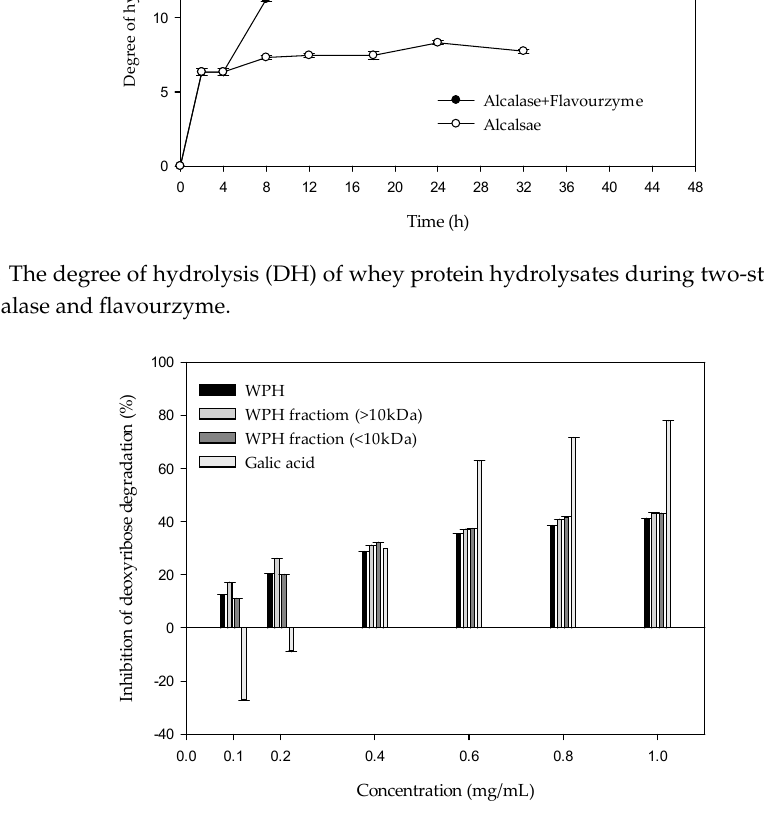
Figure 2. Effect of whey protein hydrolysate (WPH) and WPH fractions on the Fe 2+ – EDTA/H 2 O 2 / ascorbic acid (Asc)-induced oxidative damage of deoxyribose.